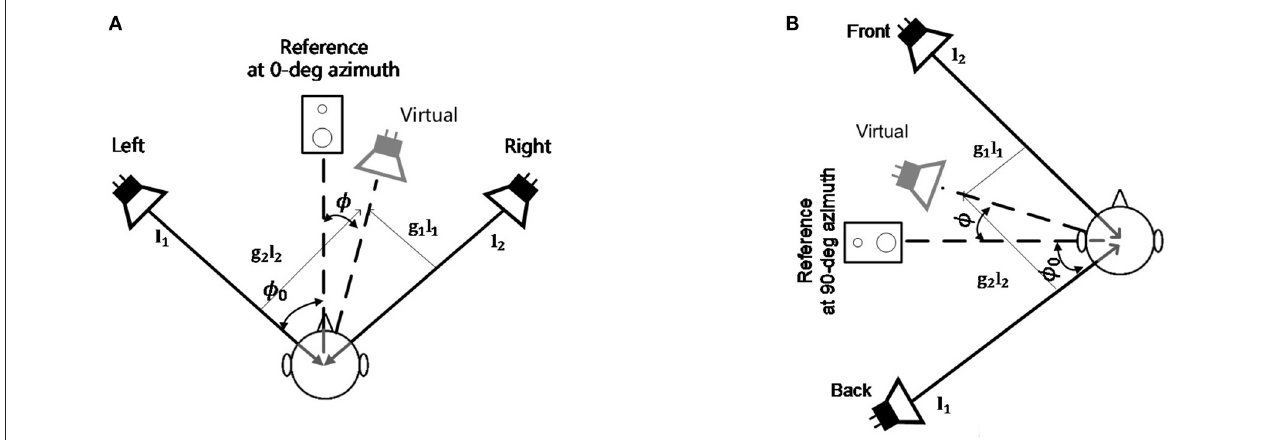
FIGURE 1 | The VBAP system configuration. (A) The configuration of the frontal MAA measurement experiment; (B) The configuration of the lateral MAA measurement